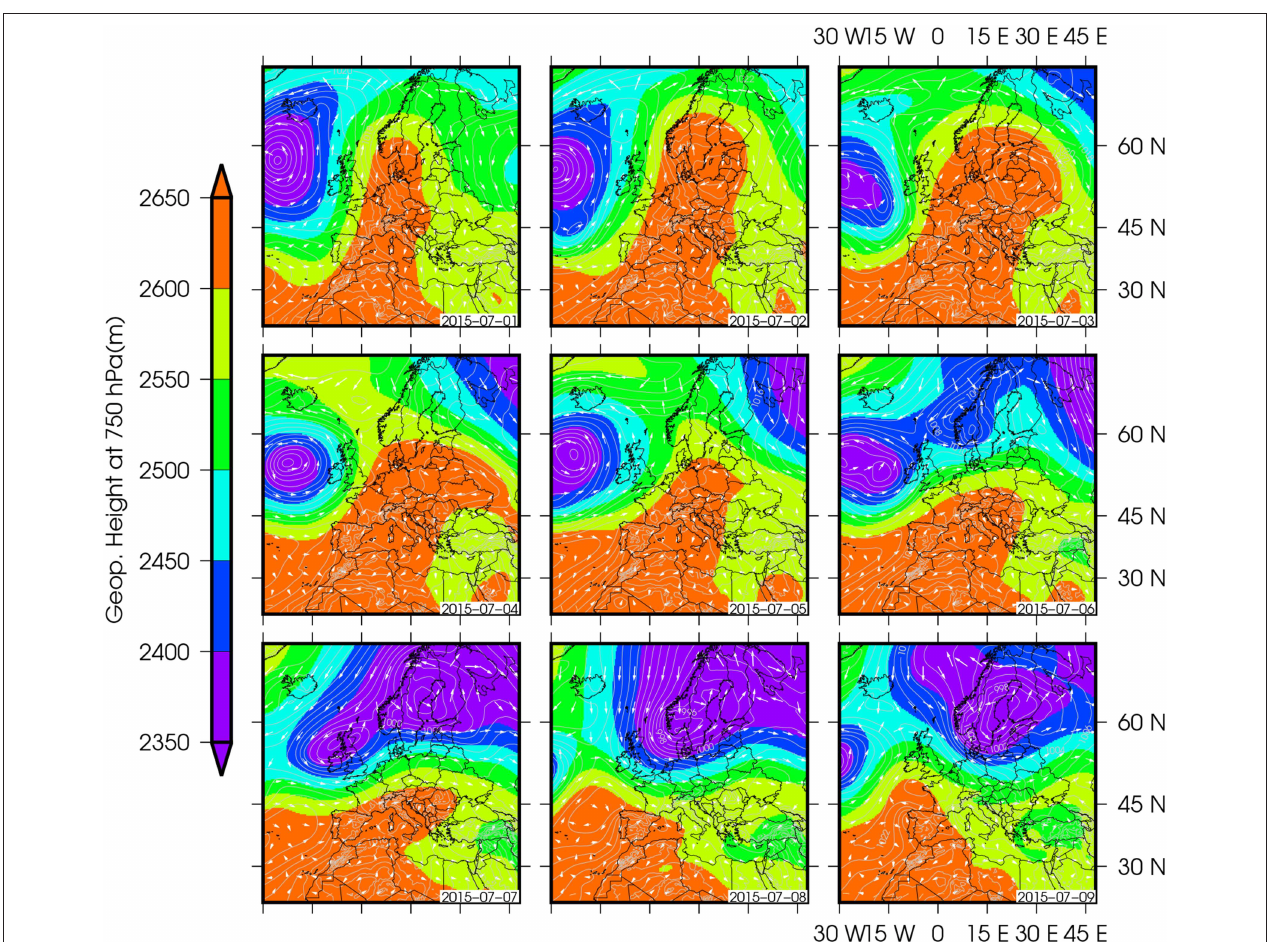
FIGURE 2 | Synoptic situation of Saharan desert dust outbreak between 1st and 9th of July 2015. Colors display geopotencial height in m at 750 hPa; white arrows, wind direction at the same pressure level; and gray lines, the sea level pressure (SLP) in